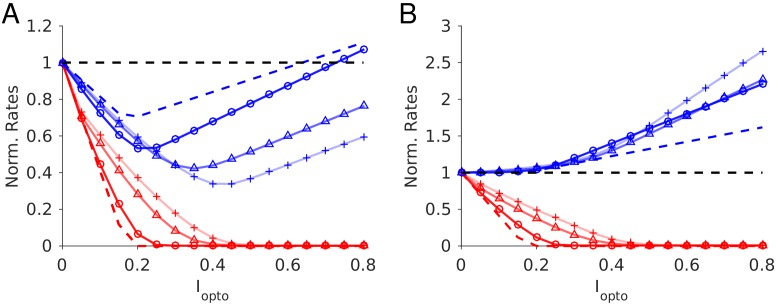
Effects of K on the responses of a two-population network to photoactivation of the inhibitory population.(A) JEE = 22 μA.ms.cm-2, the inhibitory population activity always recovers when the PCs are silenced. (B) JEE = 0, as K increases, the response of the inhibitory population becomes more and more insensitive to the perturbation. Cross: K = 50; triangles: K = 100; circles: K = 500. Dashed line: →∞. Color code and parameters as in Figure 3. Baseline firing rates: A. K = 50: rE = 10.8Hz, rI = 16.8 Hz; K = 100: rE = 8.8 Hz, rI = 14.7 Hz; K = 500: rE = 5.7 Hz, rI = 11.7 Hz; K=∞: rE = 3.9 Hz, rI = 8.5 Hz. B. K = 500: rE = 1.9 Hz, rI = 3.6 Hz; K = 100: rE = 2 Hz, rI = 4.8 Hz; K = 500: rE = 1.5 Hz, rI = 5.7 Hz; K=∞: rE = 1.4 Hz, rI = 9.1 Hz.